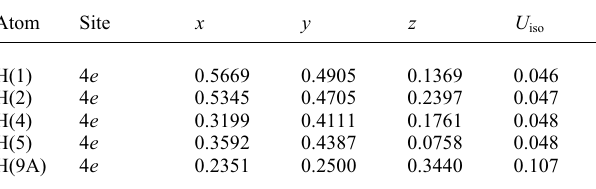
Table 2. Atomic coordinates and displacement parameters (in Å 2 )